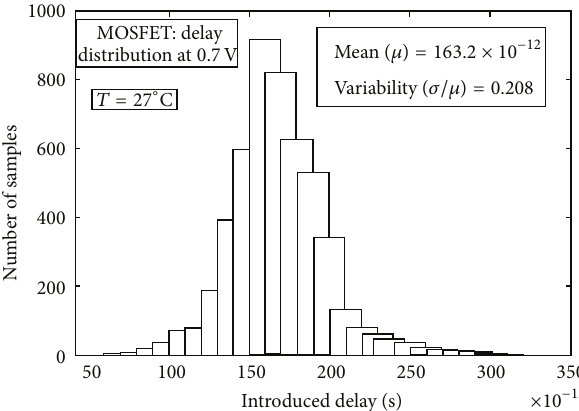
Figure 13: Introduced delay distribution plot of the MOSFET based proposed buffer delay